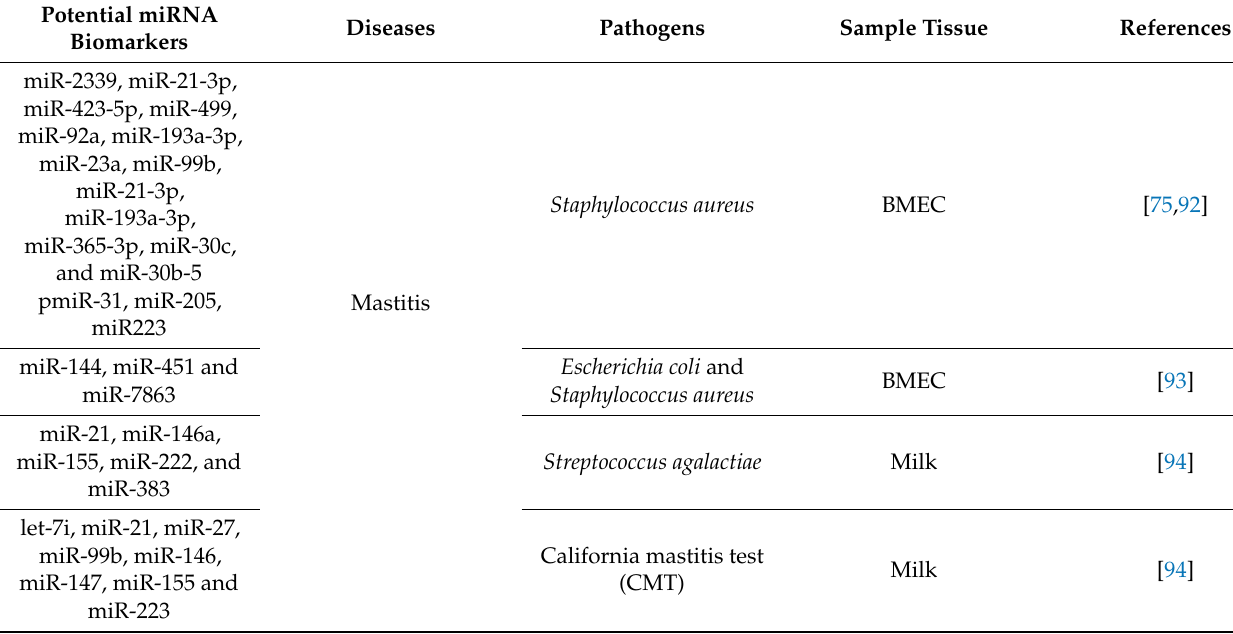
Table 2. MiRNAs involved in important diseases of ruminant